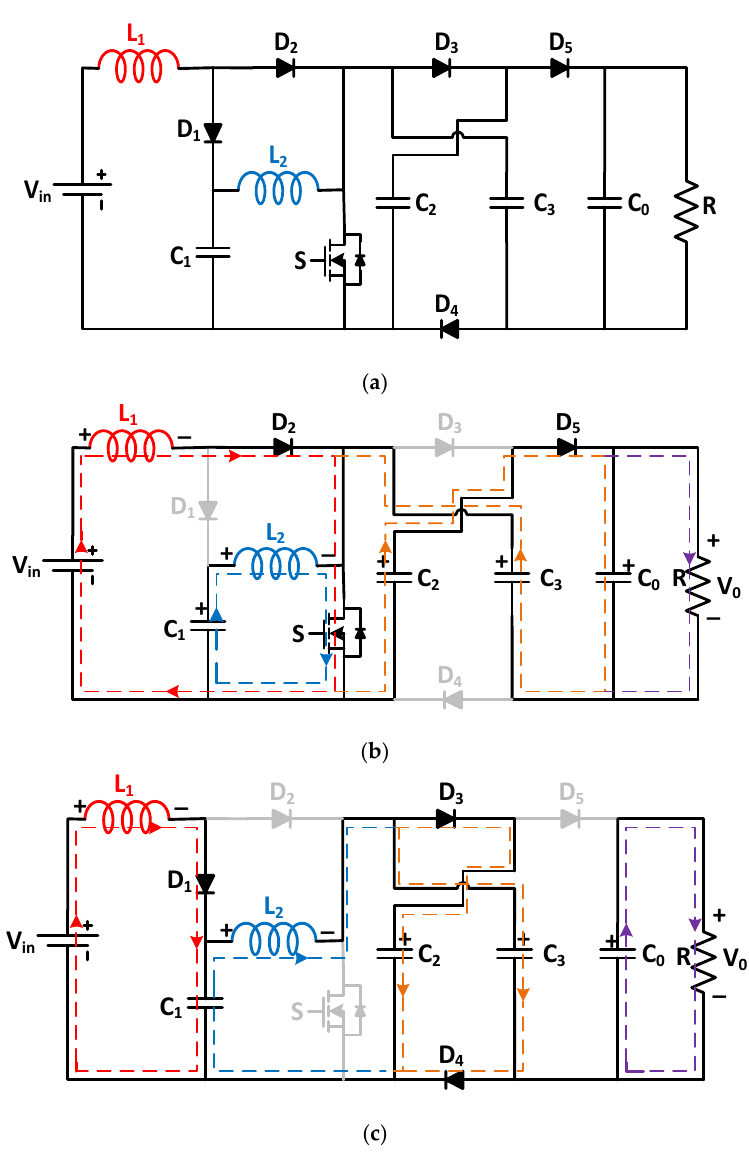
Figure 4. ( a ) Proposed converter II and operating modes: ( b ) switch is ON and ( c ) switch is OFF.